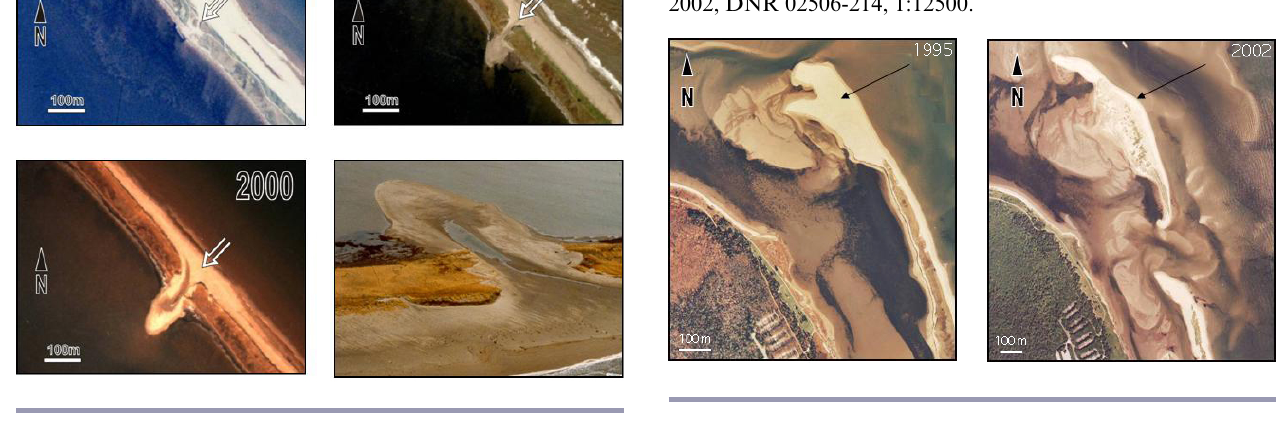
Fig. 3 . Aerial photographs showing the middle section of North Kouchibouguac Dune (site KNPn) prior to and after the 29 October 2000 storm. 1995, NAPL A31728- 28, 1:10 000.